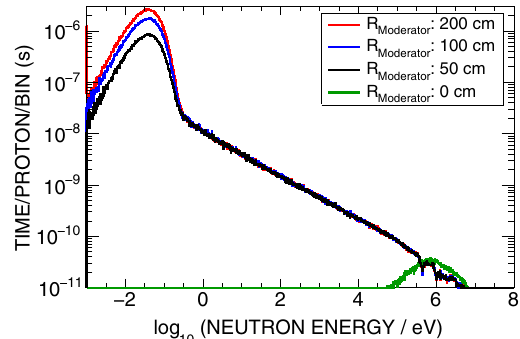
FIG. 11. Total time period neutrons spend inside the ion beam pipe as a function of the neutron energy for different moderator sizes, the small tungsten target and 800-MeV protons. Each entry corresponds to the sum of neutrons weighted with the time period the neutron spent inside the ion tube. The x-axis has a logarithmic binning with 100 bins per energy decade.